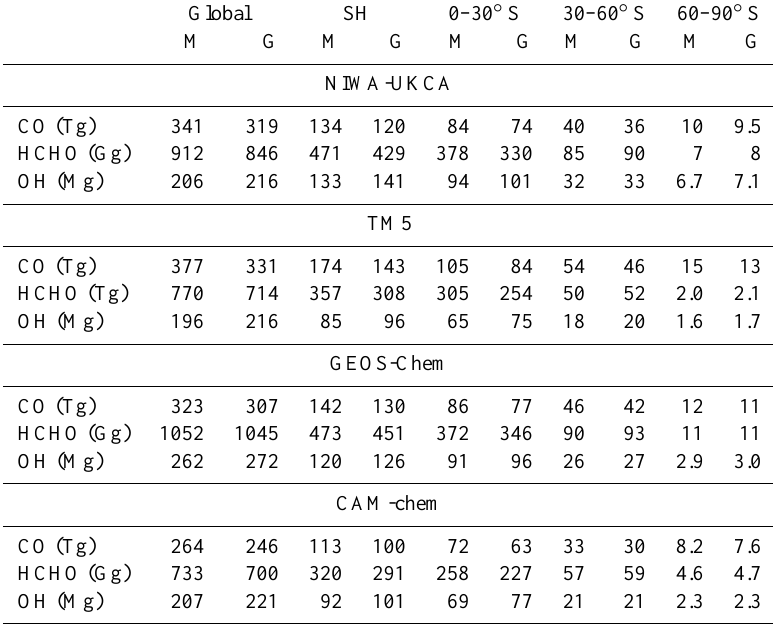
Table 6. Tropospheric CO, HCHO, and OH burden for year